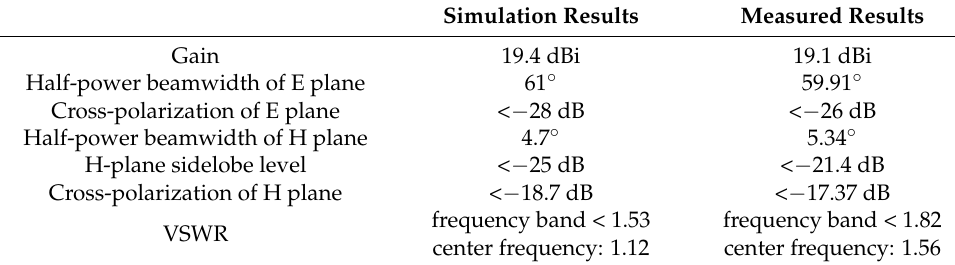
Figure 14. ( a ) Measured E-plane pattern of microstrip grid antenna; ( b ) measured H-plane pattern of microstrip grid antenna; ( c ) measured VSWR. microstrip grid antenna; ( c ) measured VSWR. Table 4. Comparison of simulation and measurement of microstrip grid antenna. Table 4. Comparison of simulation and measurement of microstrip grid